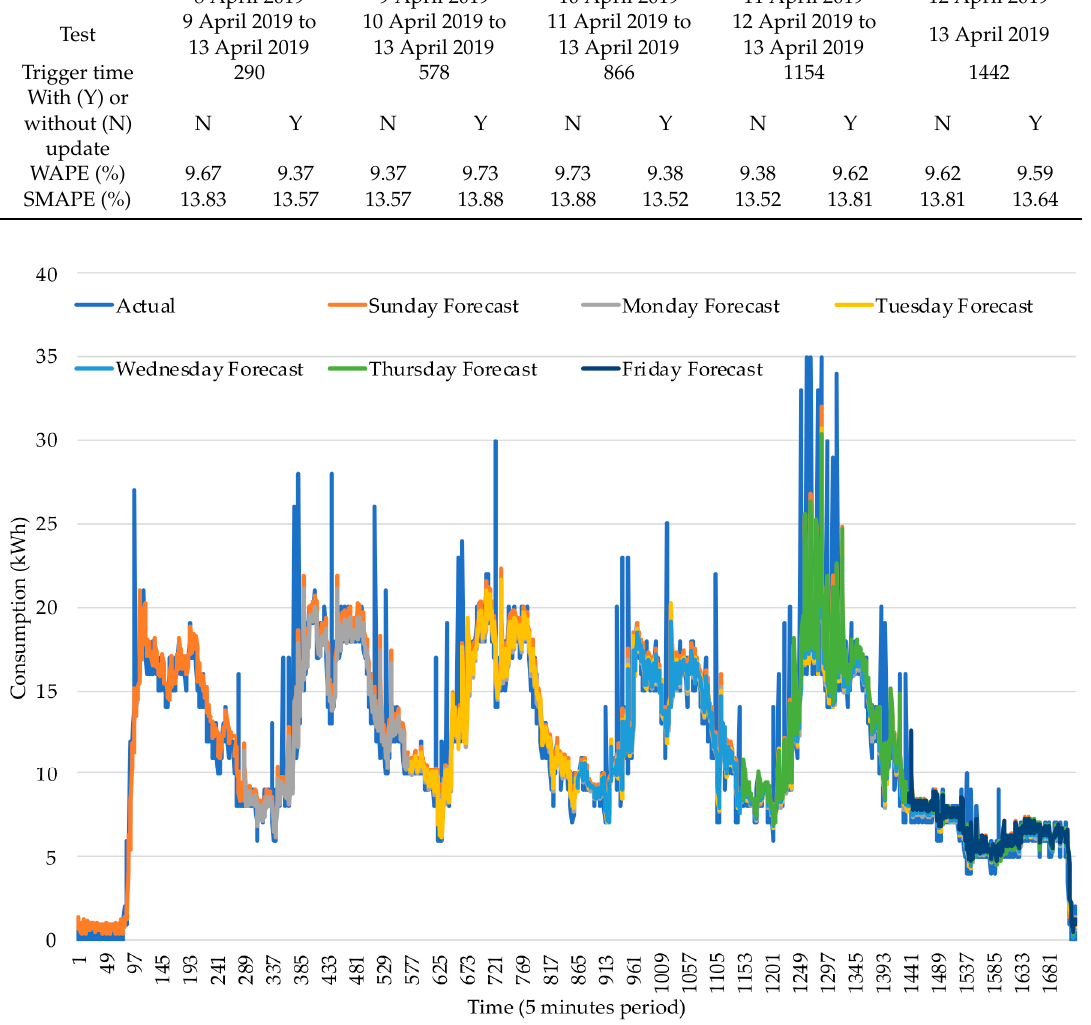
Figure 7. Consumption forecast target for period 8 to 13 April 2019.